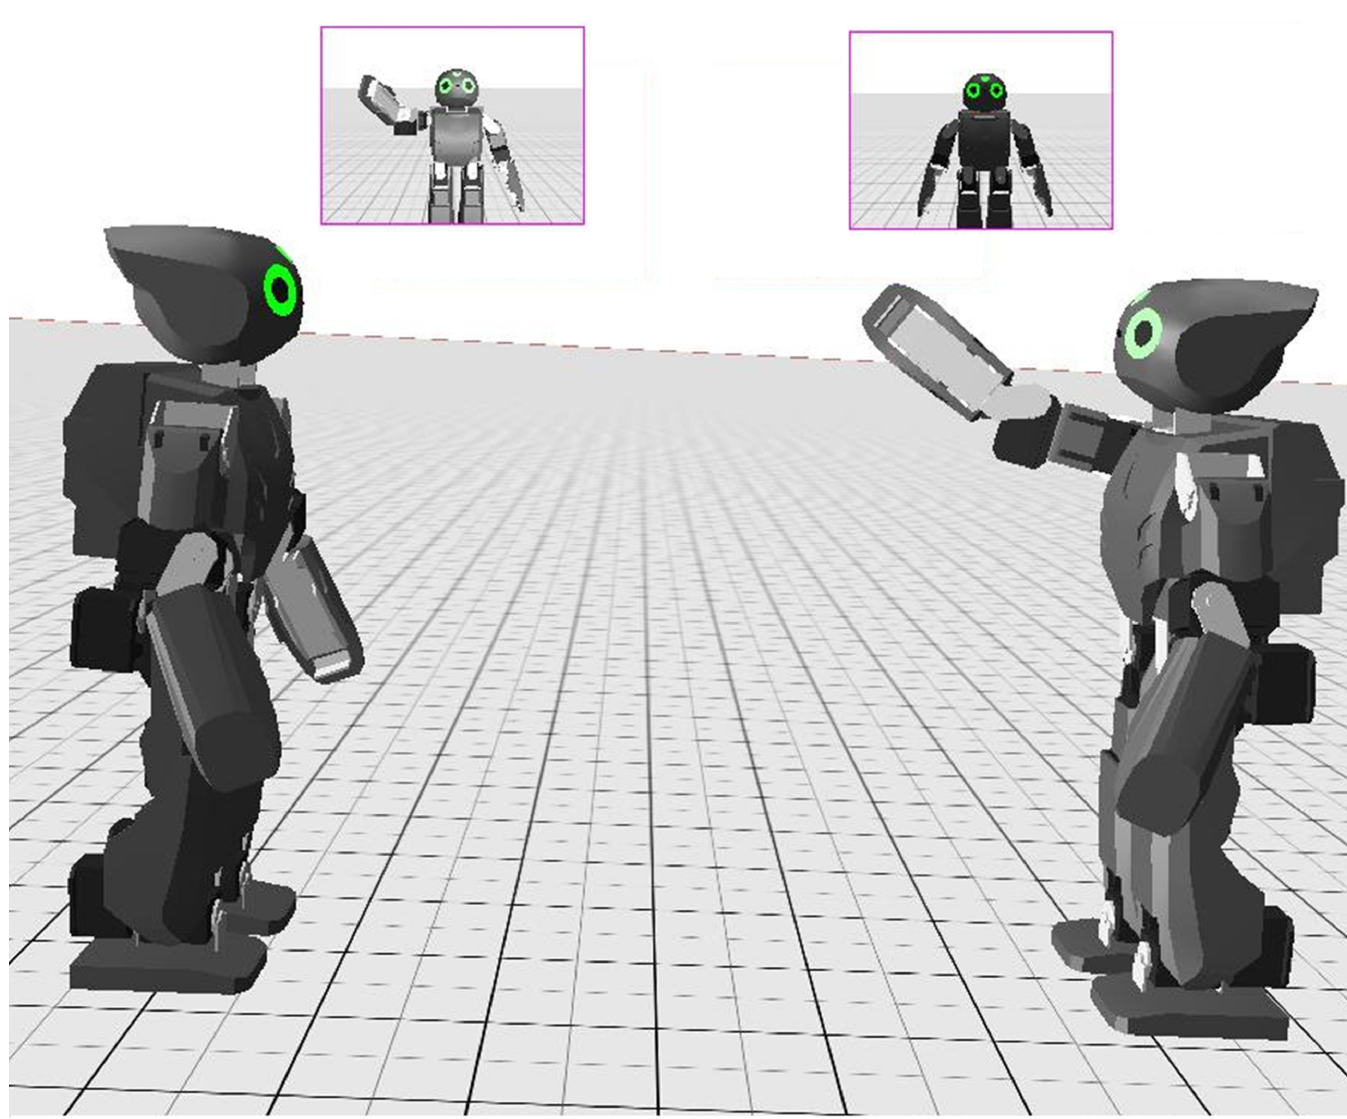
Fig 7. Simulation environment for experimentation consisting of two robots. One acts as a demonstrator (right robot), while the second acts as an observer (left